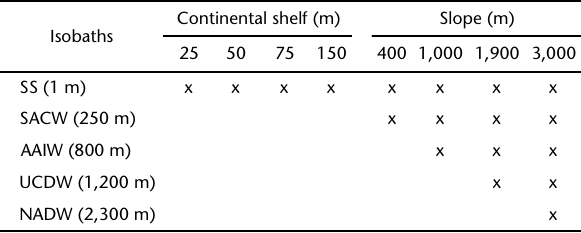
Table I. Distribution of samples in water masses (continental shelf and/or slope) in the Campos Basin, central Brazilian coast, by isobaths. In